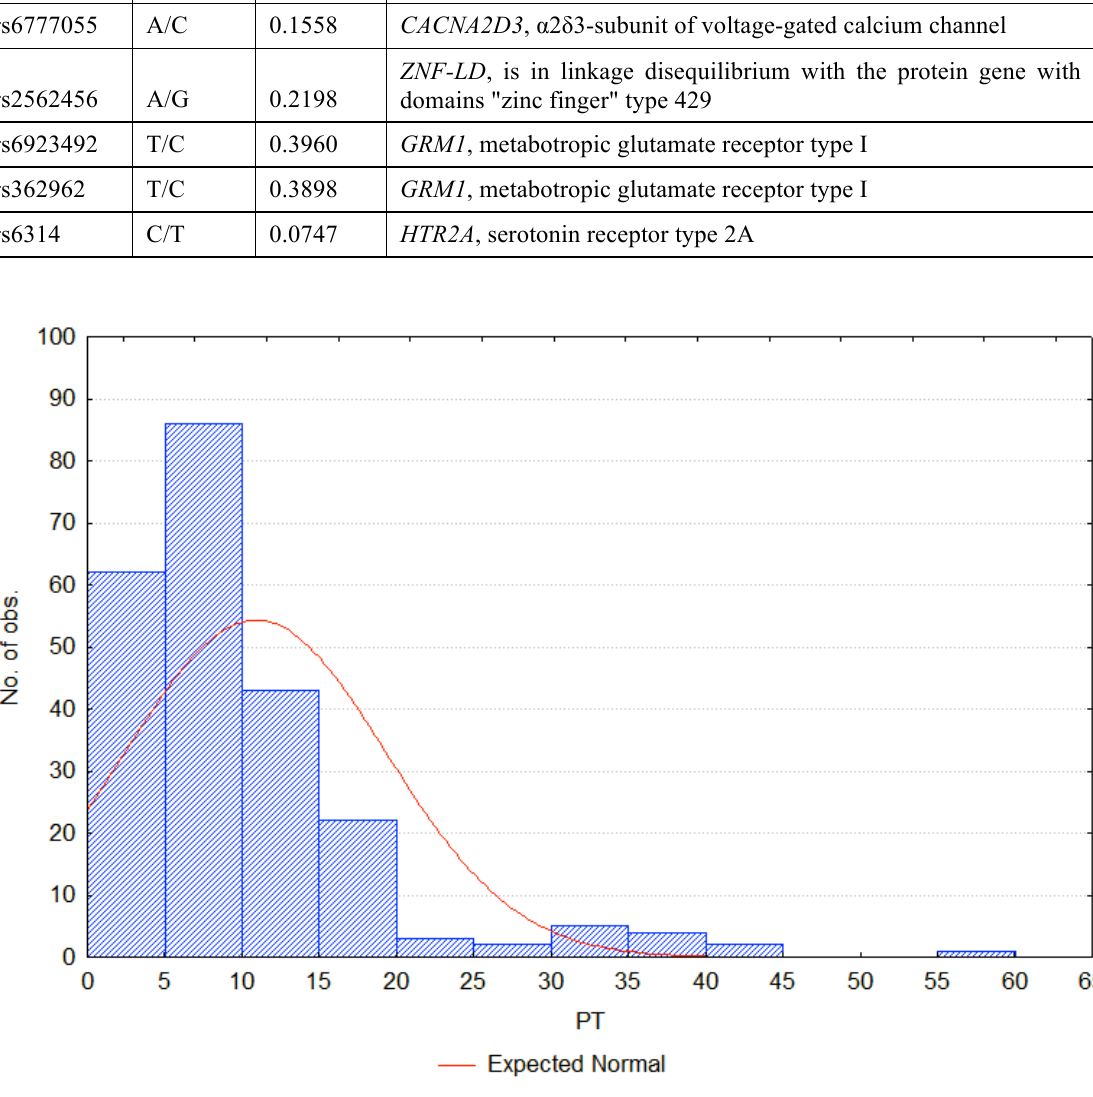
Figure 2: Distribution of PT values in the studied population before outlier